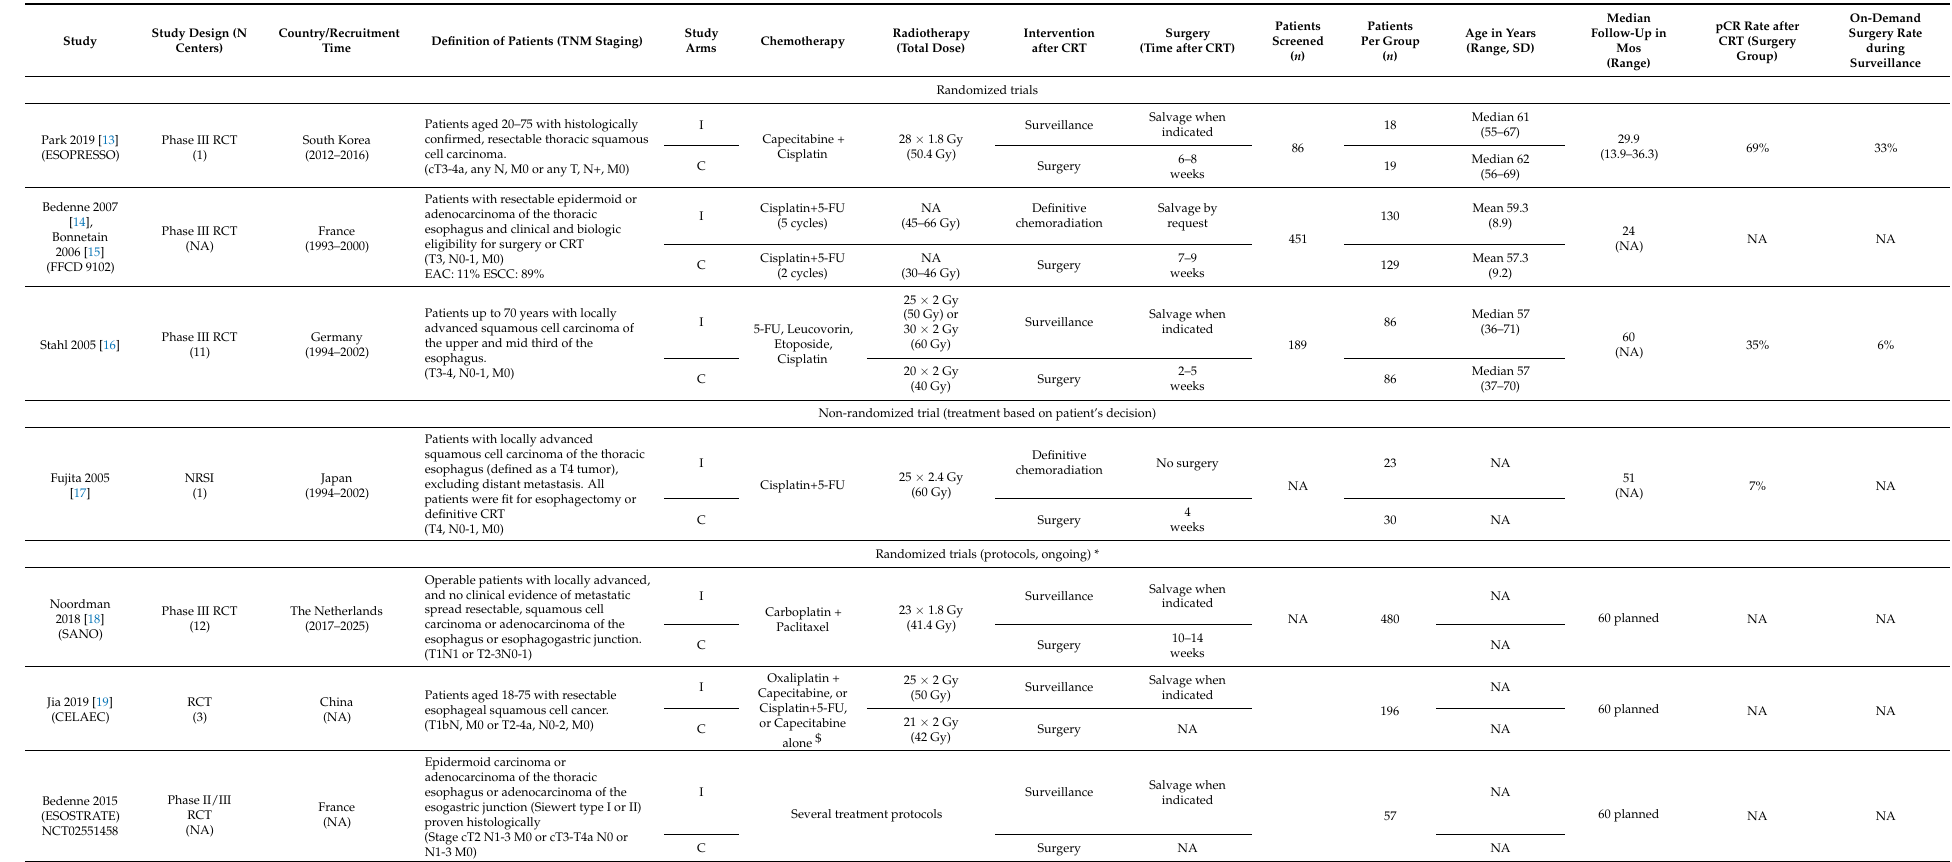
C: control, CELAEC: Chemoradiation versus oesophagectomy for locally advanced oesophageal cancer in Chinese patients, CRT: chemoradiation, EAC: esophageal adenocarcinoma, ESCC: esophageal squamous cell carcinoma, ESOPRESSO: A Randomized Phase III Trial on the Role of Esophagectomy in Complete Responders to Preoperative Chemoradiotherapy for Esophageal Squamous Cell Carcinoma, ESOSTRATE: Comparison of Systematic Surgery Versus Surveillance and Rescue Surgery in Operable Oesophageal Cancer With a Complete Clinical Response to Radiochemotherapy, FFCD: F é d é ration Francophone de Canc é rologie Digestive, I: intervention, N: number, NA: not available pCR: pathological complete response, RCT: randomized controlled trial, SANO: Surgery As Needed approach in Oesophageal cancer patients, TNM: tumor-node-metastases, 5-FU: fluorouracil. * No results published, only trial protocol is available (as of September 2020). $ Patients will receive one of the three possible treatments after a random